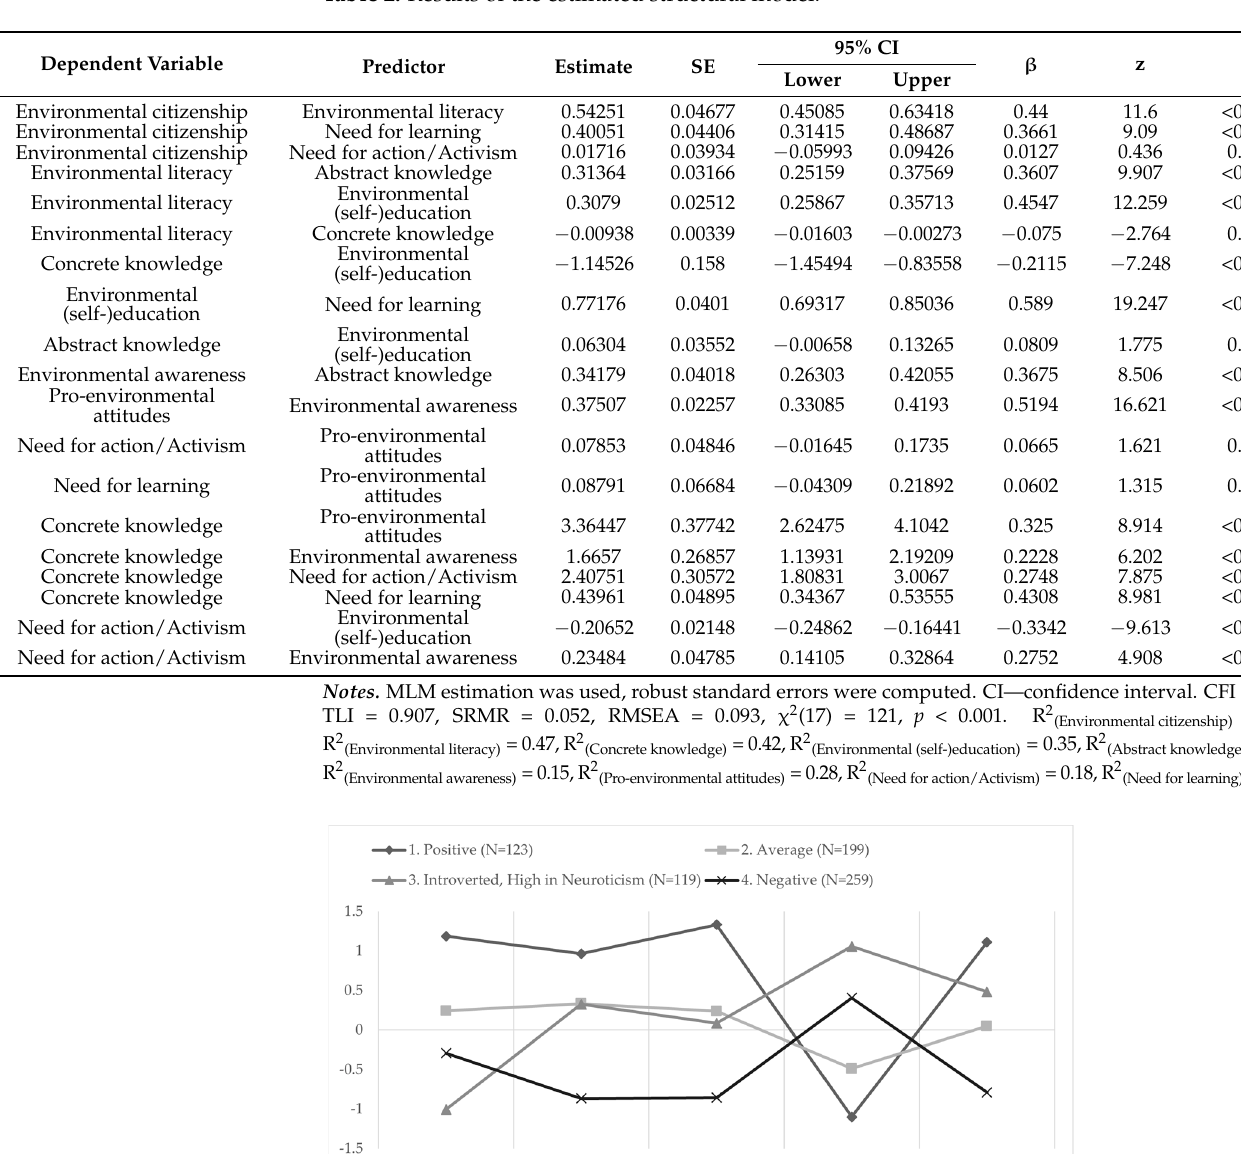
Table 2. Results of the estimated structural model.